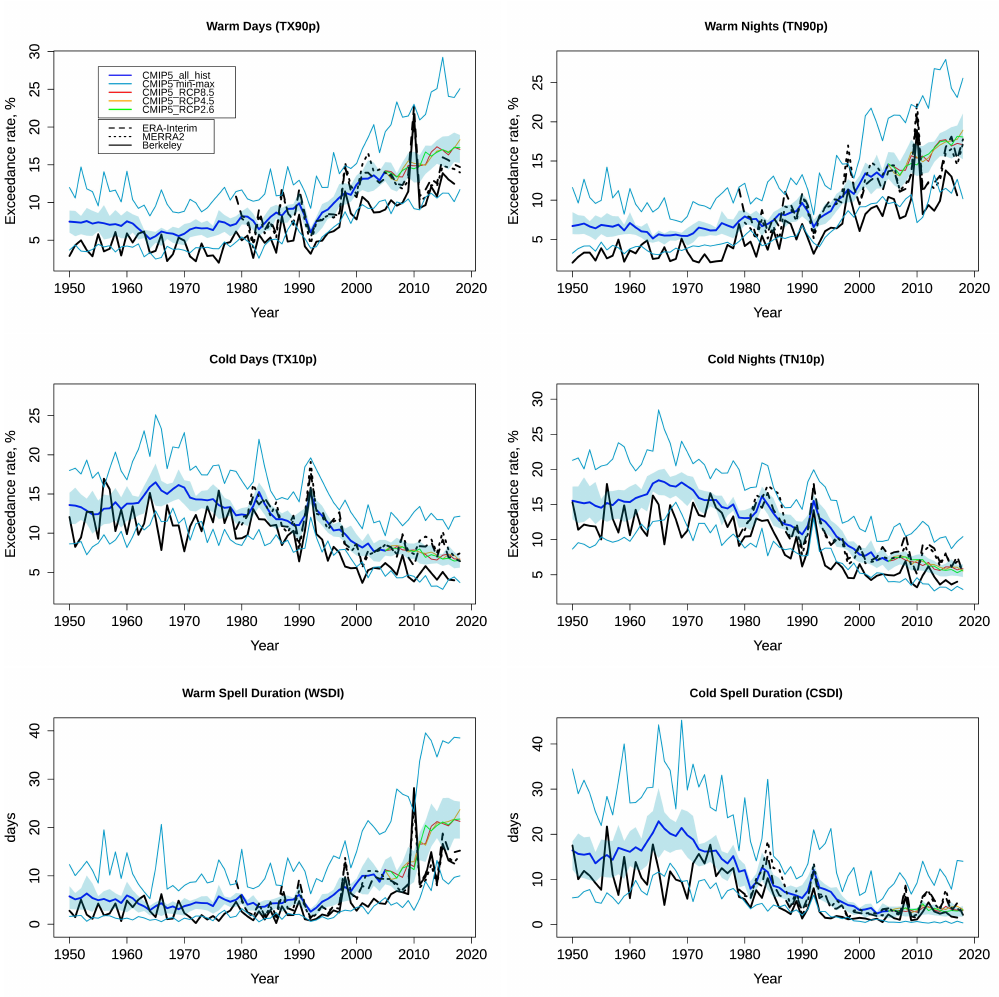
Figure 10. Annual timeseries of the MENA domain (land only) average temperature percentile and duration indices of extremes derived from: (i) CMIP5 ensemble mean (blue: historical, green: RCP 2.6, yellow: RCP 4.5, red: RCP 8.5). The blue shading indicates the inter-quartile model range and the light blue lines represent the maximum and minimum values. (ii) Observational data (black lines, dashed: ERA-Interim, fine dashed: MERRA-2, solid: Berkeley